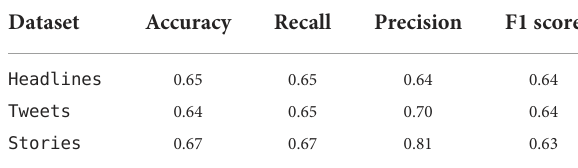
TABLE 2 Summary of the